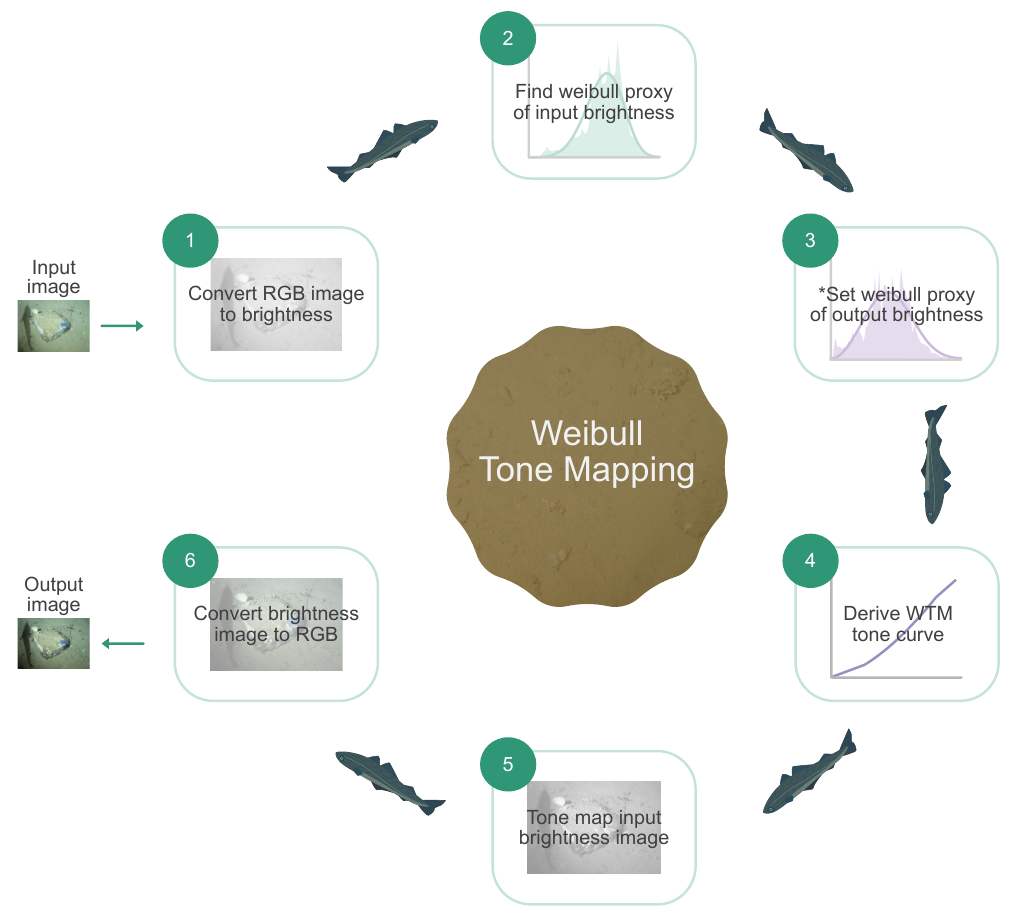
Figure 6. Weibull Tone Mapping flow chart. * Note that, in Step 3. we specify parameters ( λ & k ) to create a desired WD (Equation (7)). This creates an original WTM enhancement. However, Step 3 can, alternatively, approximate an existing tonal enhancement from its adjusted brightness distribution (Equation (8)). Further description of the flow chart steps is provided in